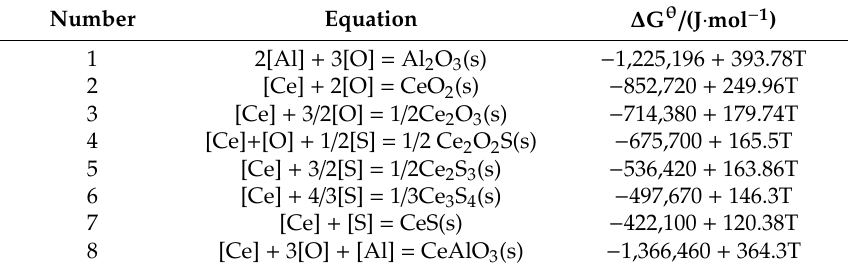
Table 5. Reaction equation and the standard Gibbs free energy [29–33].